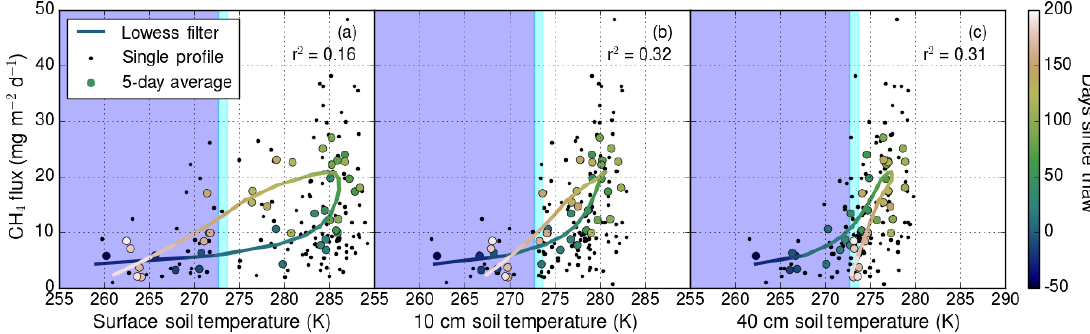
Figure 7. (a–c) CH 4 flux estimates from atmospheric profiles are shown versus footprint-weighted mean soil temperatures at different depths. The shaded background denotes when the soil temperature was at (cyan) or below (blue) the fusion point of water.